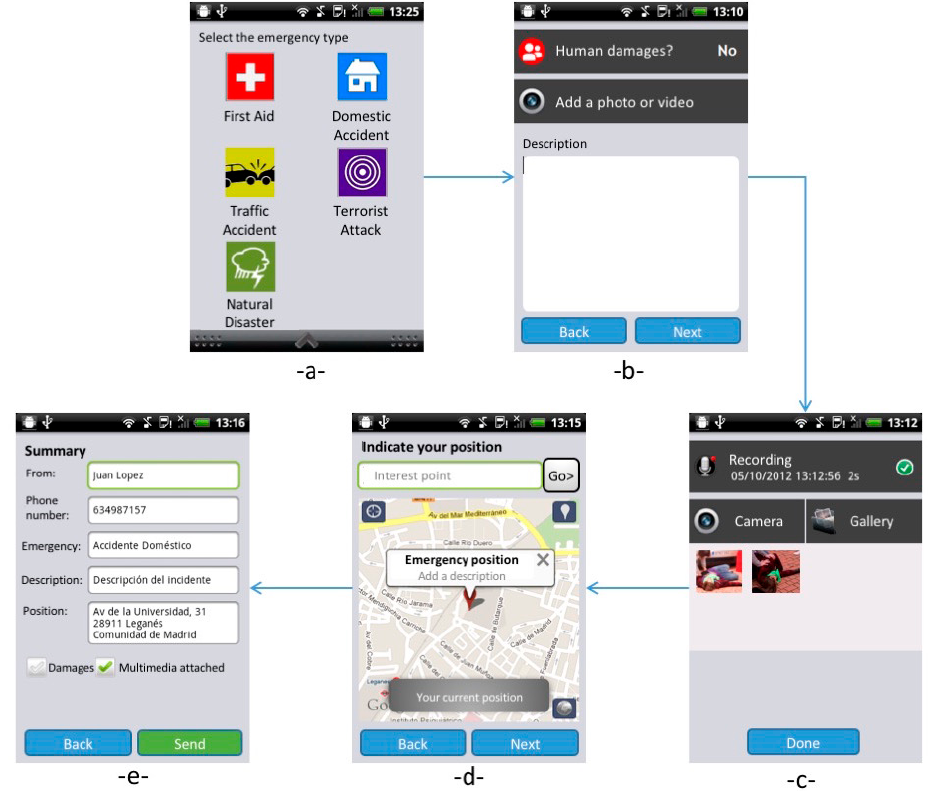
Figure 1. Application screen flow: - a - the emergency category list, - b - the textual description, - c - the multimedia content, - d - the localization map, - e - the message resume